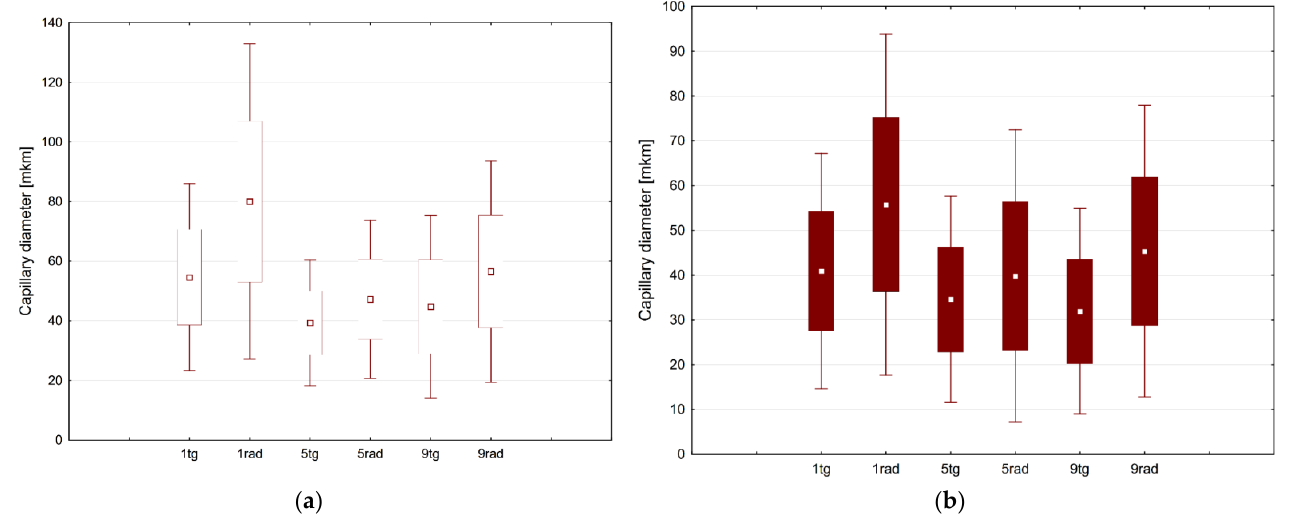
Figure 4. Boxplot visualizations of the effect of different trunk heights on stemwood vessel diameters of ( a ) Betula pendula Roth. and ( b ) Populus tremula L. transverse sections.